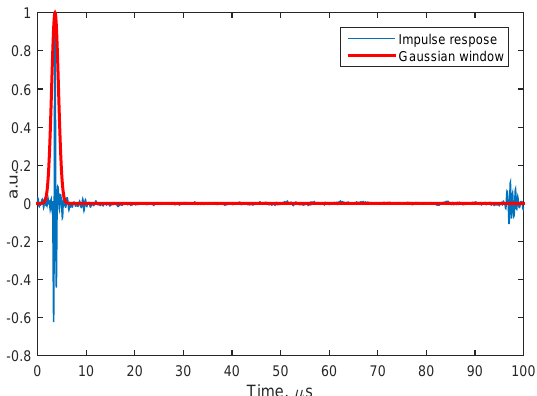
Figure 2. The real part of the system impulse response in a given spatial point acquired by the laser. The Gaussian window (in red) allowed filtering undesired multiple reflections.